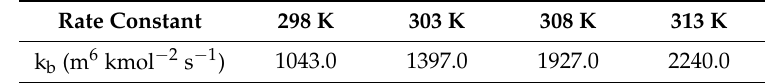
Table 8. Reaction rate constants at different temperatures using termolecular